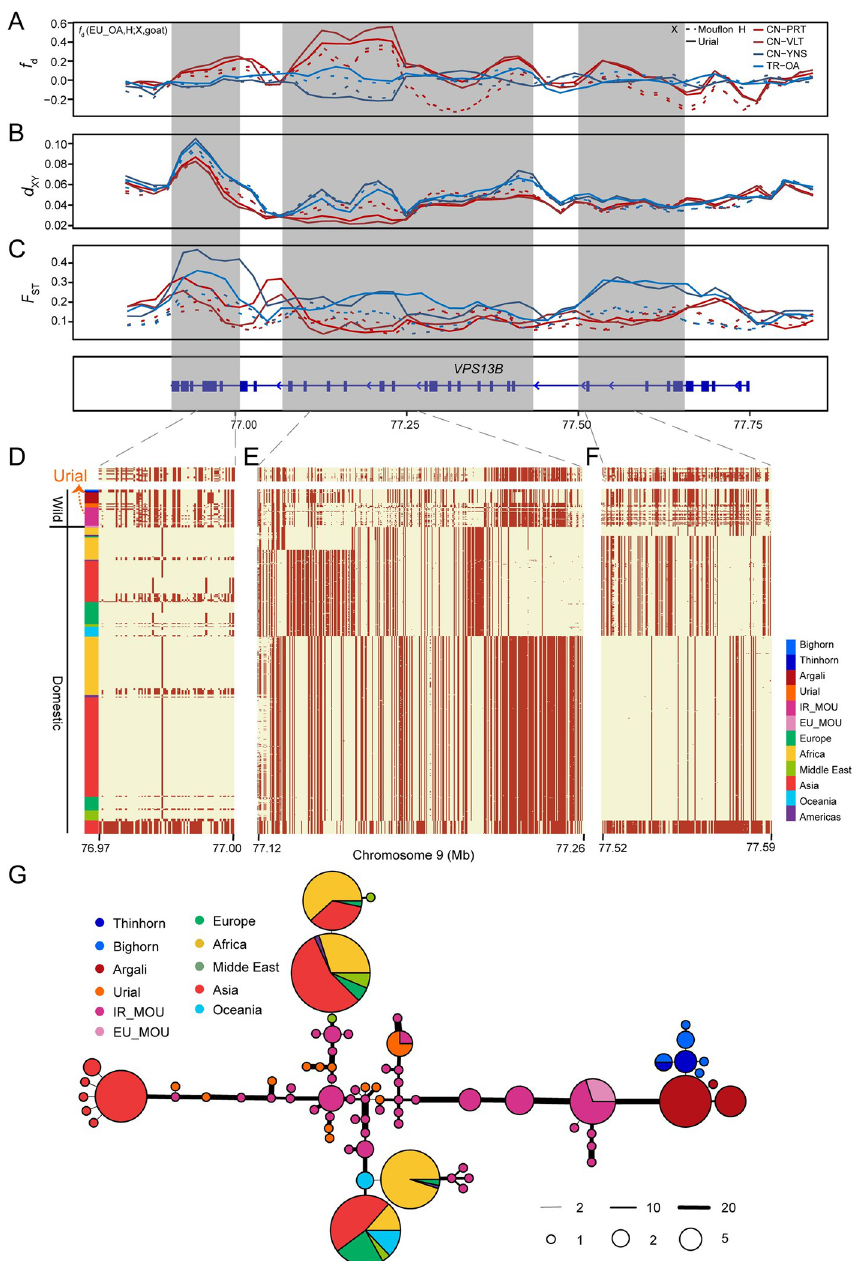
Fig 6. Signals of introgression in the VPS13B gene. (A-C) Distributions of f d (EU_OA, X; Urial, Goat), d XY , and F ST extending the three introgressed regions. The gene structures of VPS13B are indicated at the bottom track. (D-F) The patterns of haplotype sharing for part of introgressed regions. Each row is a phased haplotype, and each column is a polymorphic SNP variant. The reference and alternative alleles are indicated in light yellow and red, respectively. These signals were also supported by d and F values which were lower between intro- XY ST gressed haplotypes and urial than mouflon, despite the closer phylogenetic position of the later to domestic sheep ( Figs 6B , 6 C and S29 ). Whereas, this pattern was almost undetectable in partial introgressed region. We built haplotype networks of each region to investigate in detail